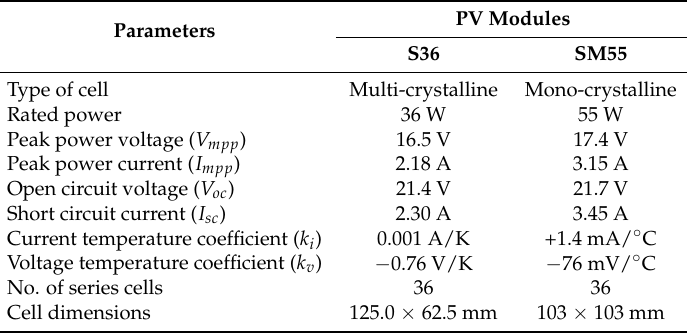
Figure 3. Partial shading analysis on S36 PV module ( a ) Shading patterns patterns, ( b ) I-V curves and ( c ) P-V curves. Table 2. Specifications of solar PV